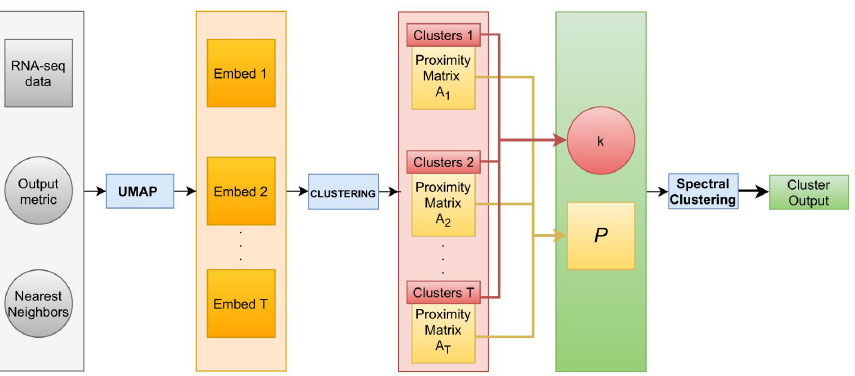
Figure 1. Methodological workflow of our pipeline. Starting from RNA-seq data, on the left, given an output metric and number of NN (our hyperparameters), we generated T UMAP embeddings, onto which we applied a clustering algorithm. Then, we set k equal to the mode of the number of clusters identified by the clustering technique on T embeddings and we computed the affinity matrix P by summing all T proximity matrices related to each clustering result. Finally, we applied spectral clustering on P with k groups to obtain one final reproducible cluster.